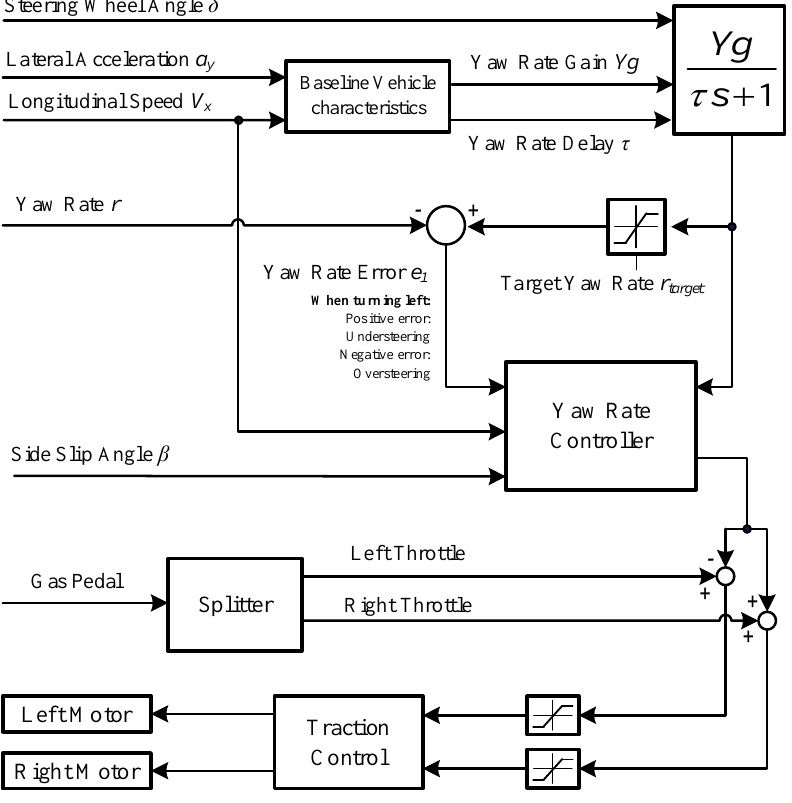
Figure 2. General controller scheme.